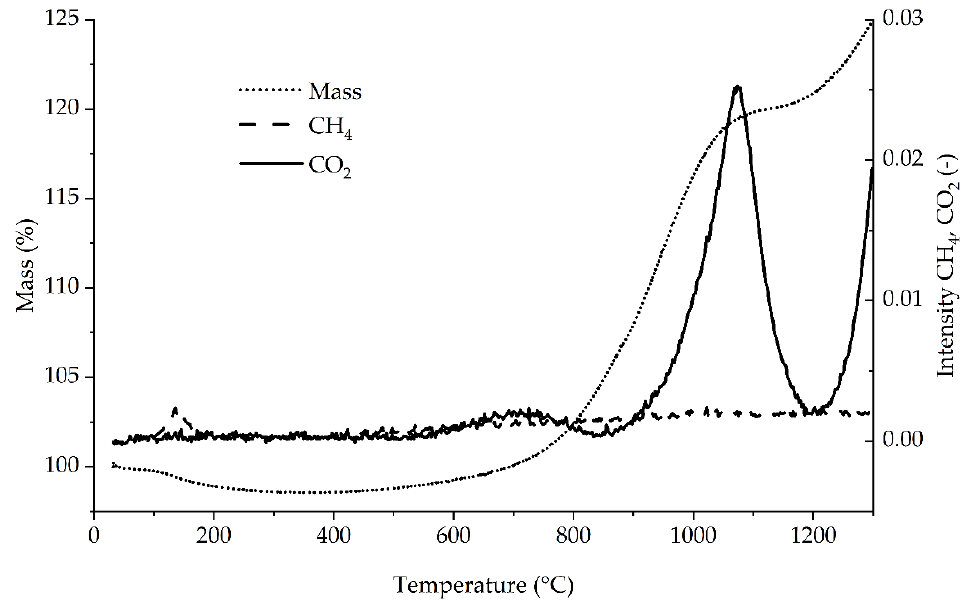
Figure 6. TGA-IR analysis of the untreated Al 4 C 3 powder sample in air. Starting at 30 °C with a temperature ramp of 5 °C/min.